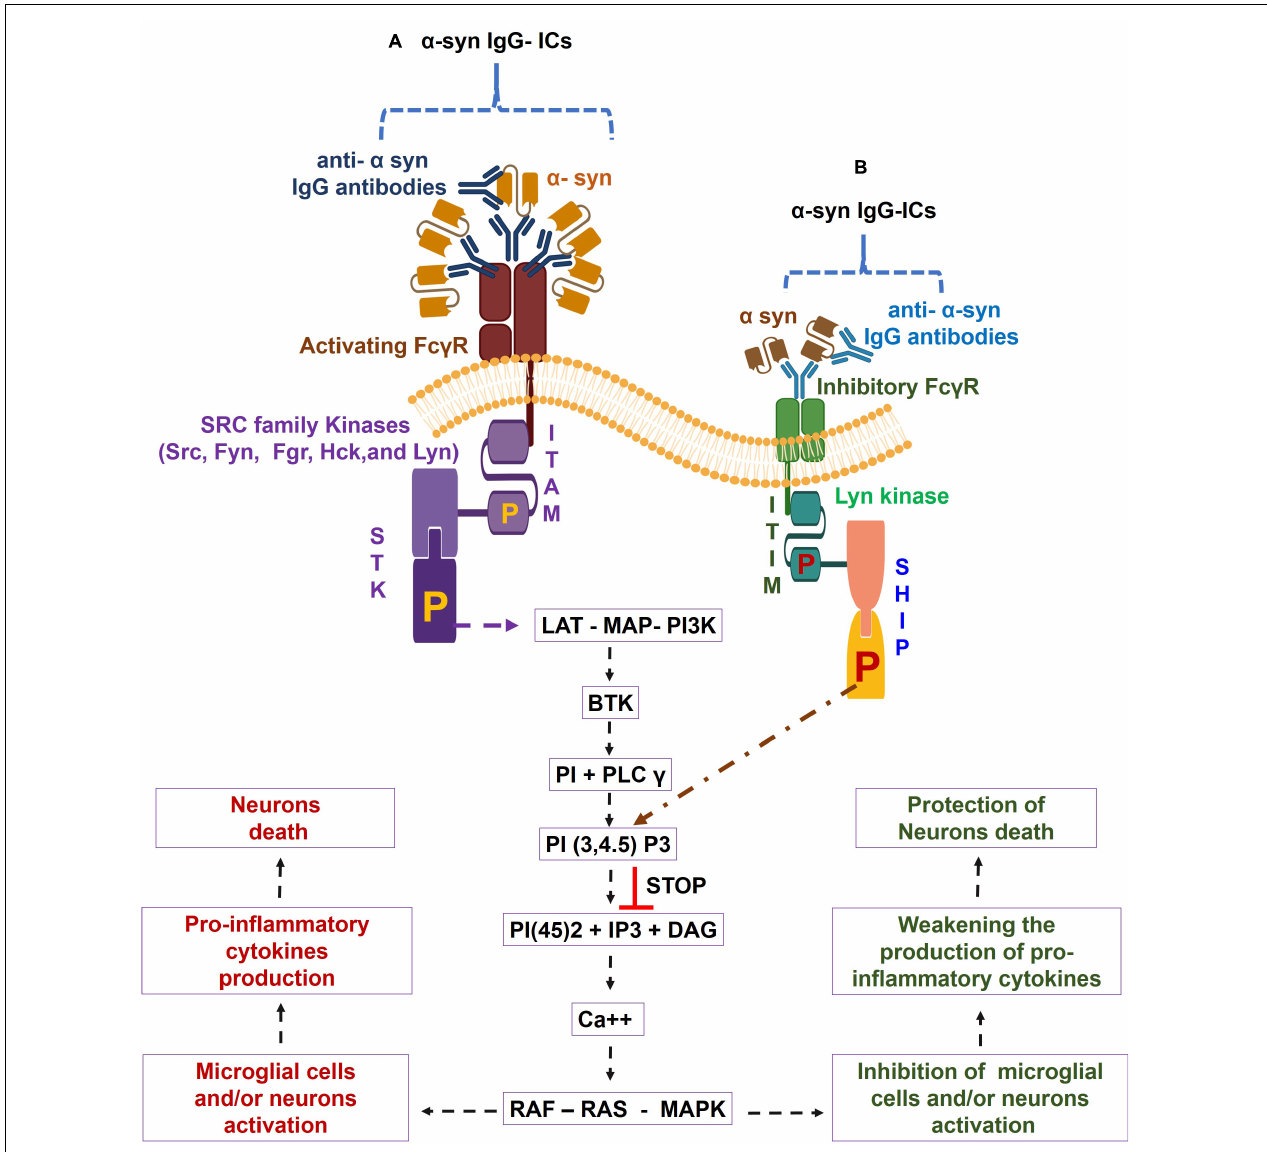
FIGURE 1 | Alpha-synuclein-specific IgG immune complexes ( α -syn-IgG-ICs) – Fc gamma receptor (Fc γ R) function in induction of neuroinflammation in aged humans. During aging, α -syn- IgG-ICs interaction with the activating Fc γ R activates the SRC family kinases, (e.g., Src, Fyn, Fgr, Hck, and Lyn). These enzymes trigger the phosphorylation of immune-tyrosine activation motif (ITAM) and cause the recruitment of SH2 domain having Syk kinases, which lead to the phosphorylation of spleen tyrosine kinase (STK). Such alteration in STK causes the activation of the linker for activation of T cells (LAT)- multimolecular adaptor complexes (MAC)- phosphoinositide 3-kinase (PI3K) – Bruton’s tyrosine kinase (BTK) – phosphoinositide base (PI) + phospholipase C-gamma (PLC- γ ) – phosphatidylinositol (3,4,5)-trisphosphate : PI(3,4,5)P 3 – phosphoinositol 4,5 diphosphate [PI(4,5) 2 ] + Inositol 1,4,5 triphosphate (IP3) + diacyl glycerol (DAG) – calcium (Ca ++ ) – rat sarcoma virus (RAS) – rapidly accelerated fibrosarcoma (RAF) – mitogen-activated protein kinase (MAPK) pathway and cause increased activation of microglial cells and/or neurons and pro-inflammatory cytokines generation, which lead to neuron death in aged humans (A) . Furthermore, due to aging-induced down regulation of inhibitory Fc γ R, α syn-IgG-ICs fail to establish proper binding to the inhibitory Fc γ R and, in turn, the inhibitory Fc γ R- downstream LYN kinases- phosphorylated immunoreceptor tyrosine inhibitory motif (ITIM) – phosphorylated SH2-containing-phosphatidylinositol-5 (cid:48) -phosphatase (SHIP) anti-inflammatory pathway do not control the α syn- IgG-ICs – activated Fc γ Rs axis- mediated microglial cells and/or neurons activation, pro-inflammatory cytokines generation, and the neurons death in aged humans (B)